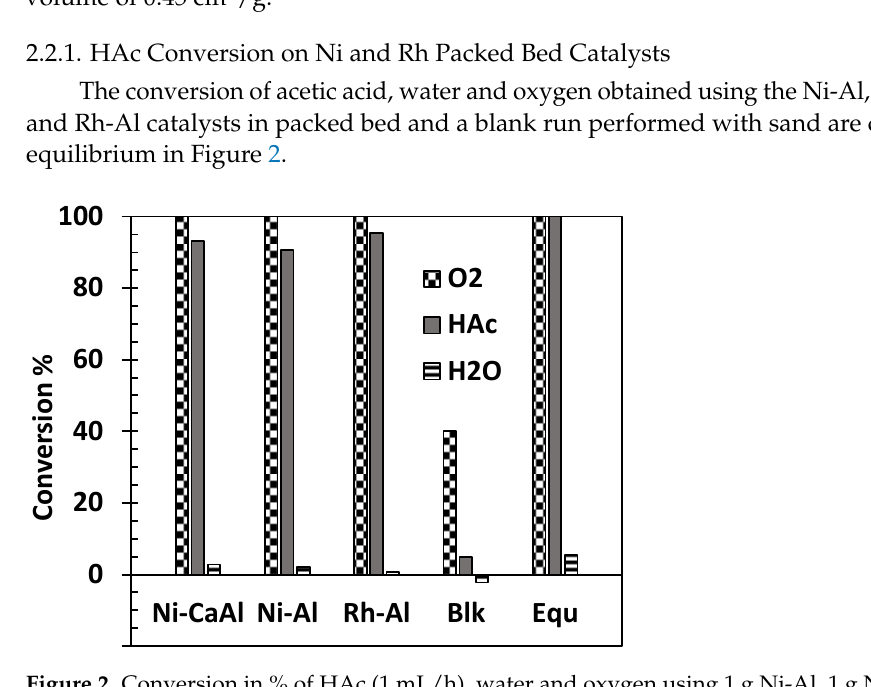
Table 2. Morphological properties of Ni and Rh packed bed catalysts.